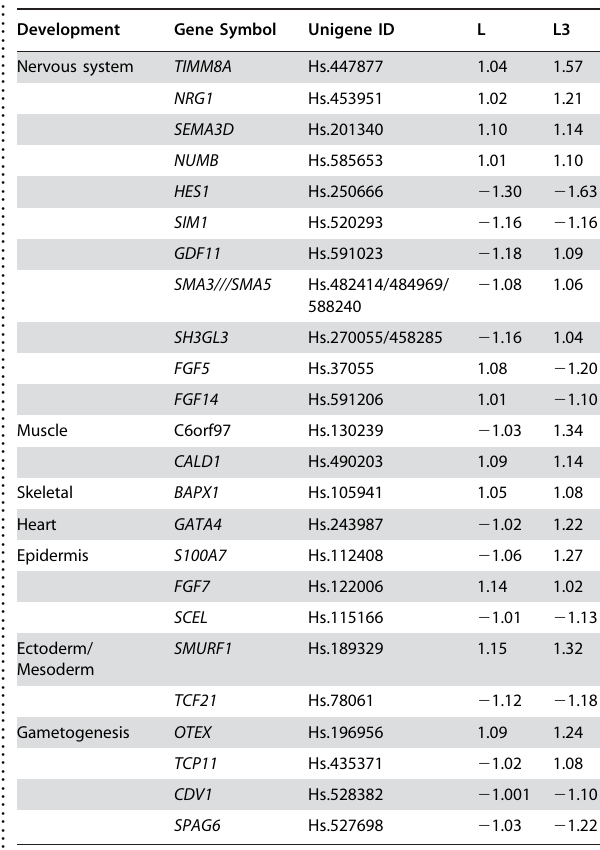
Table 2. Development gene fold-changes in